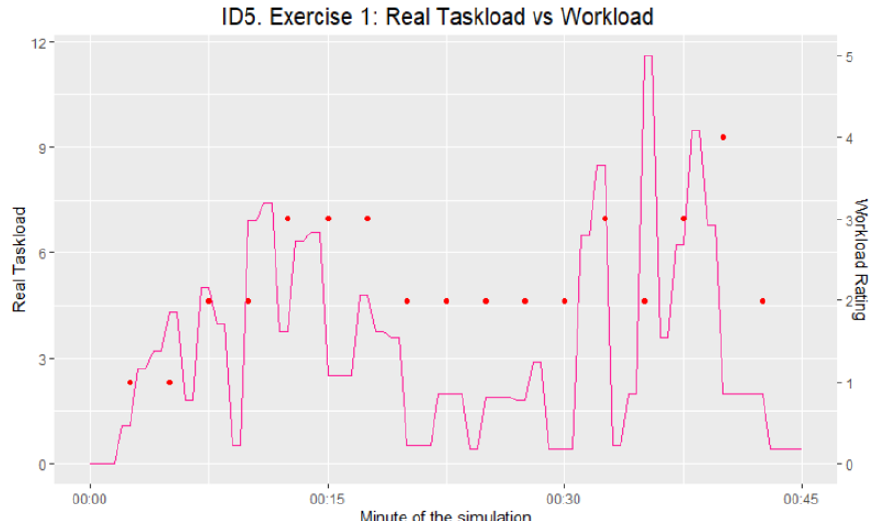
Figure 6. Comparison between the actual taskload profile obtained for Exercise 1 of Participant 5 and the workload values assessed by the participant during the simulation. the workload values assessed by the participant during the